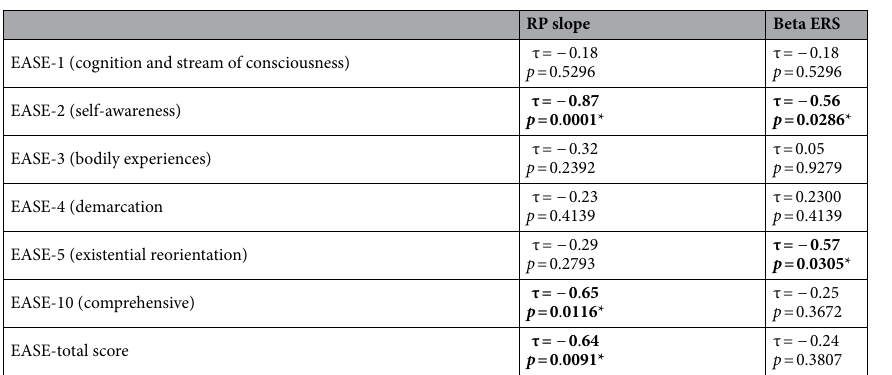
Table 2. Correlations between pre/post-movement electroencephalographic (EEG) correlates and Self- Disorders in patients. The slope of the Readiness Potential (RP) was calculated at C1 electrode in the interval − 650 ms to − 100 ms. Beta event-related synchronization (ERS) was calculated at C1-FC1 cluster as the cumulate of the beta event-related spectral perturbation (ERSP) in time bins showing significant differences compared to healthy controls. Correlations with specific items from the Examination of Anomalous Self-Experience (EASE) are shown.